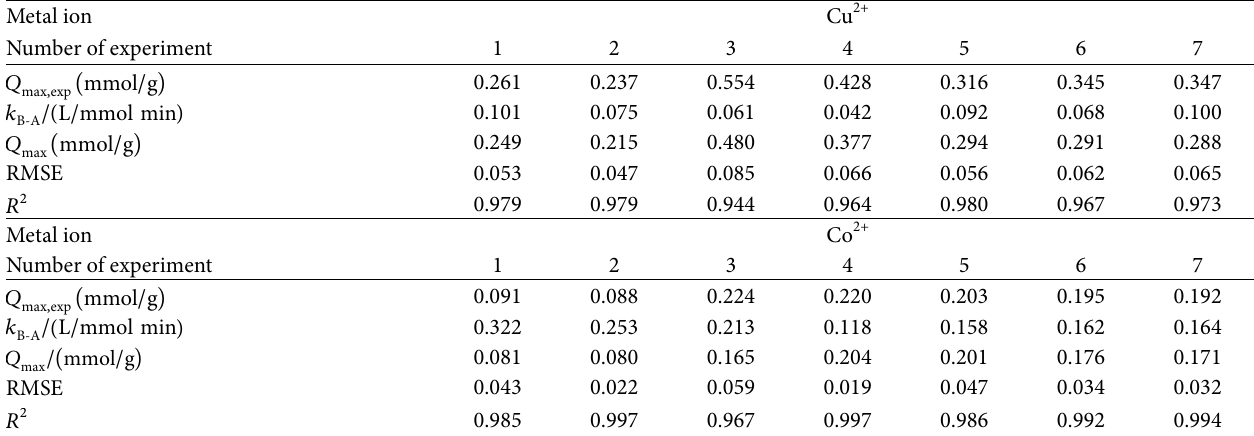
Table 7: Results of the modeling the experimental breakthrough curves with the Bohart–Adams model for adsorption of Cu 2+ and Co 2+ on SBox adsorbent in a fixed-bed column at